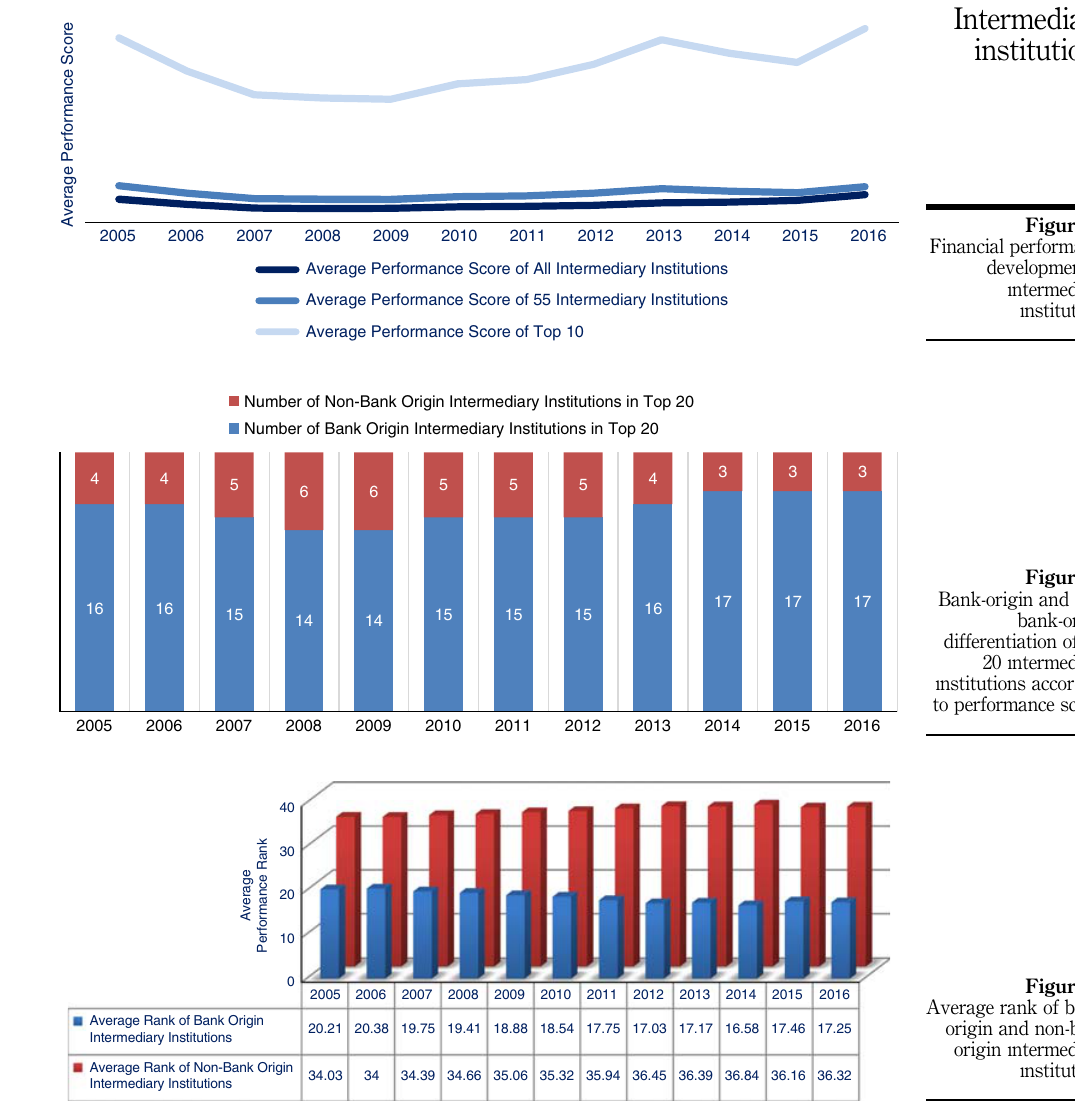
Figure 1. Financial performance